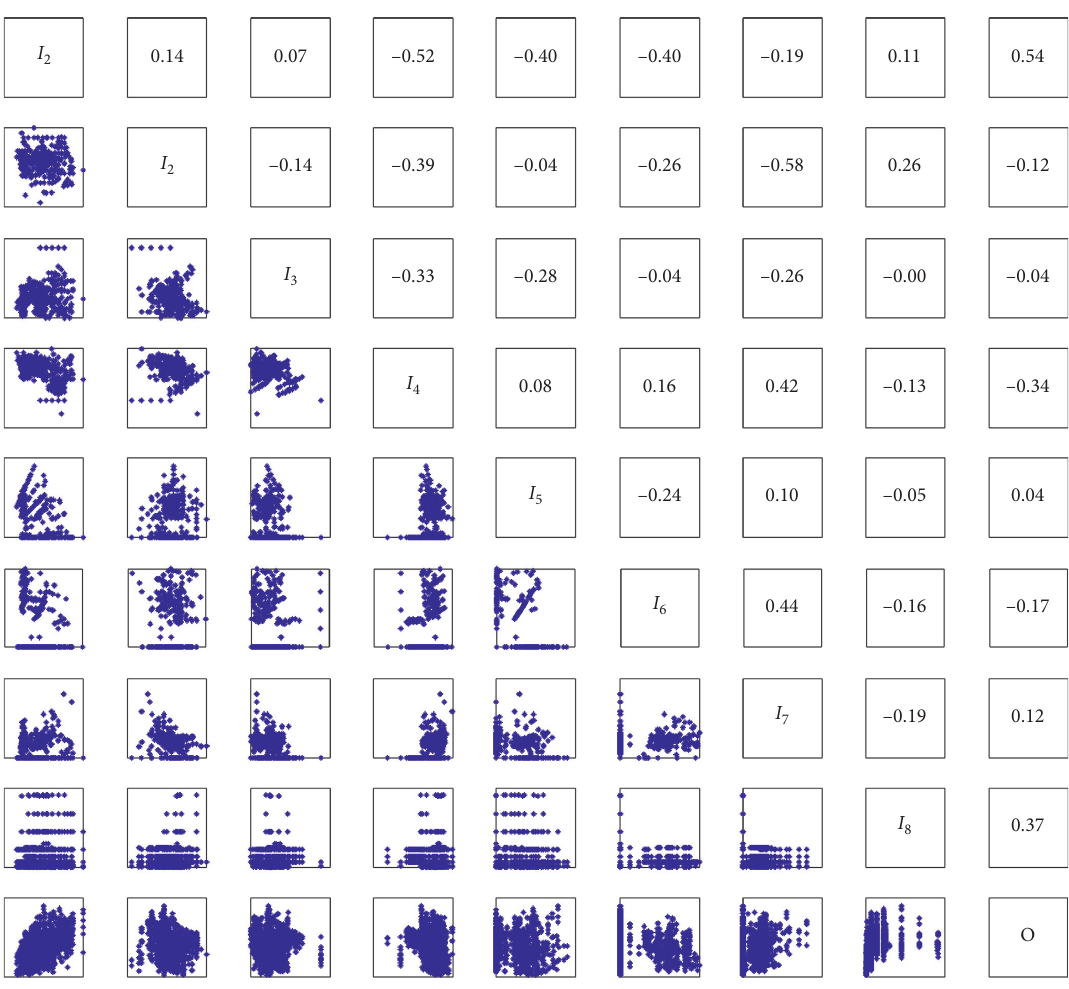
Figure 2: Multicorrelation graph of input and output variables used in this study.